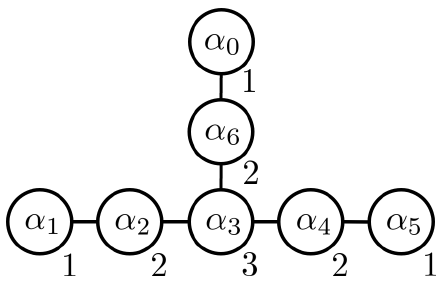
Figure 6 . Depiction of the affine Dynkin diagram of E 6 . The nodes are associates to the roots α i of E and their Kac-labels. The node associtated to α 6